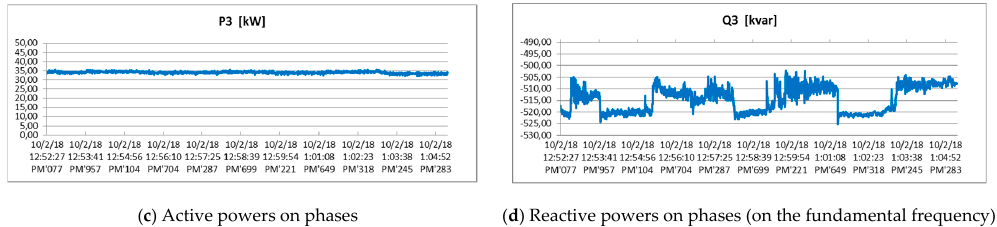
Figure 2. Records of the values of the electrical amounts at the beginning of the analyzed line.